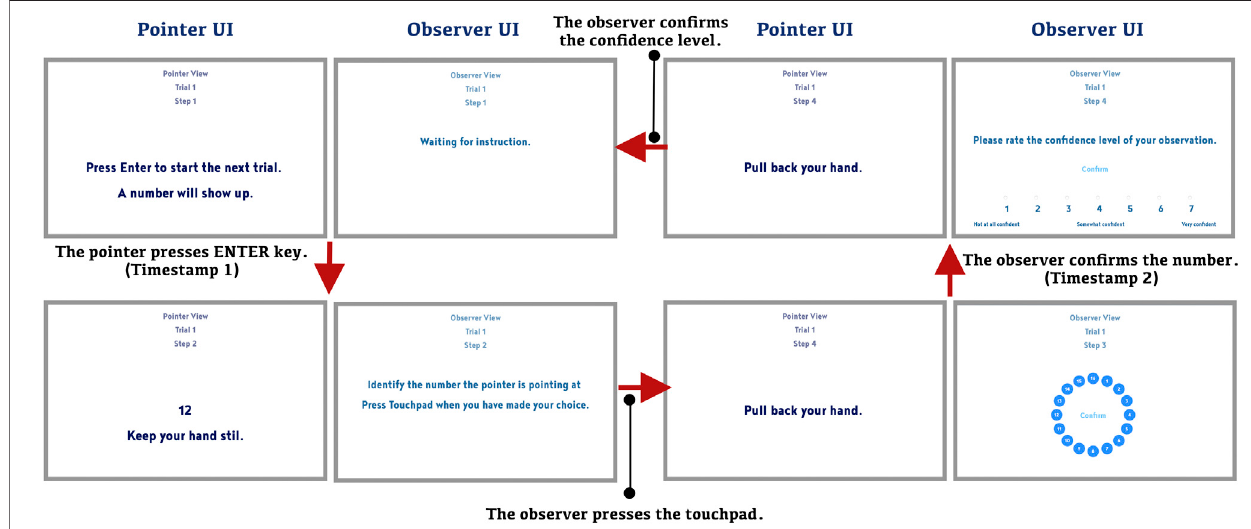
FIGURE 4 | Flowchart of experiment UI for one experimental trial, starting from the upper-left pair of screens.